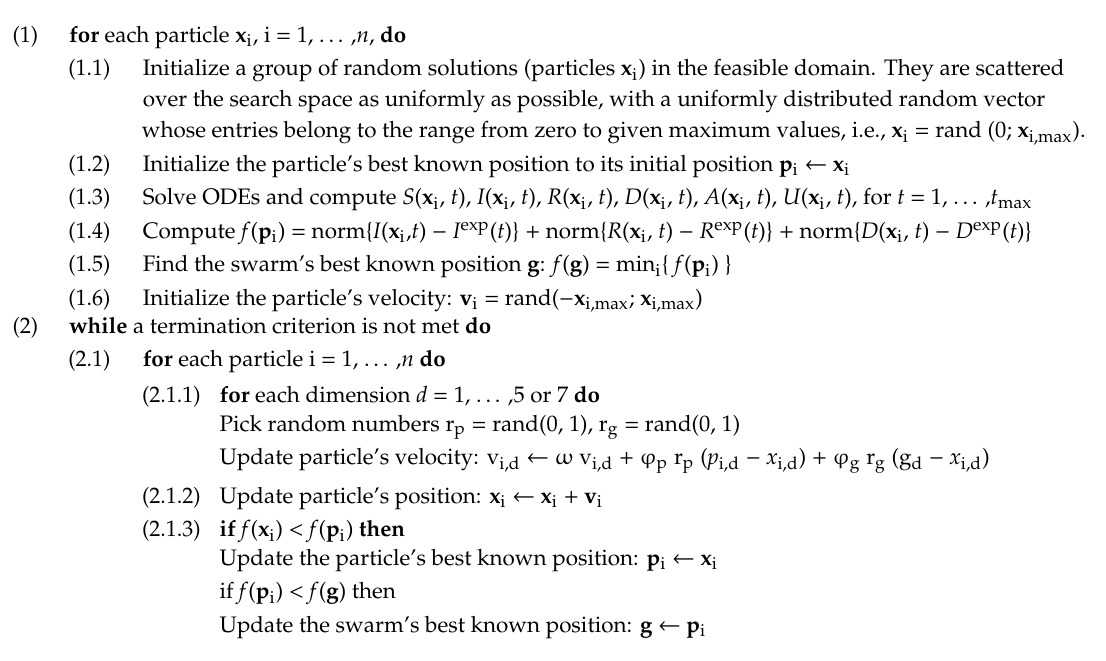
Algorithm 1. Machine learning algorithm for model parameters’